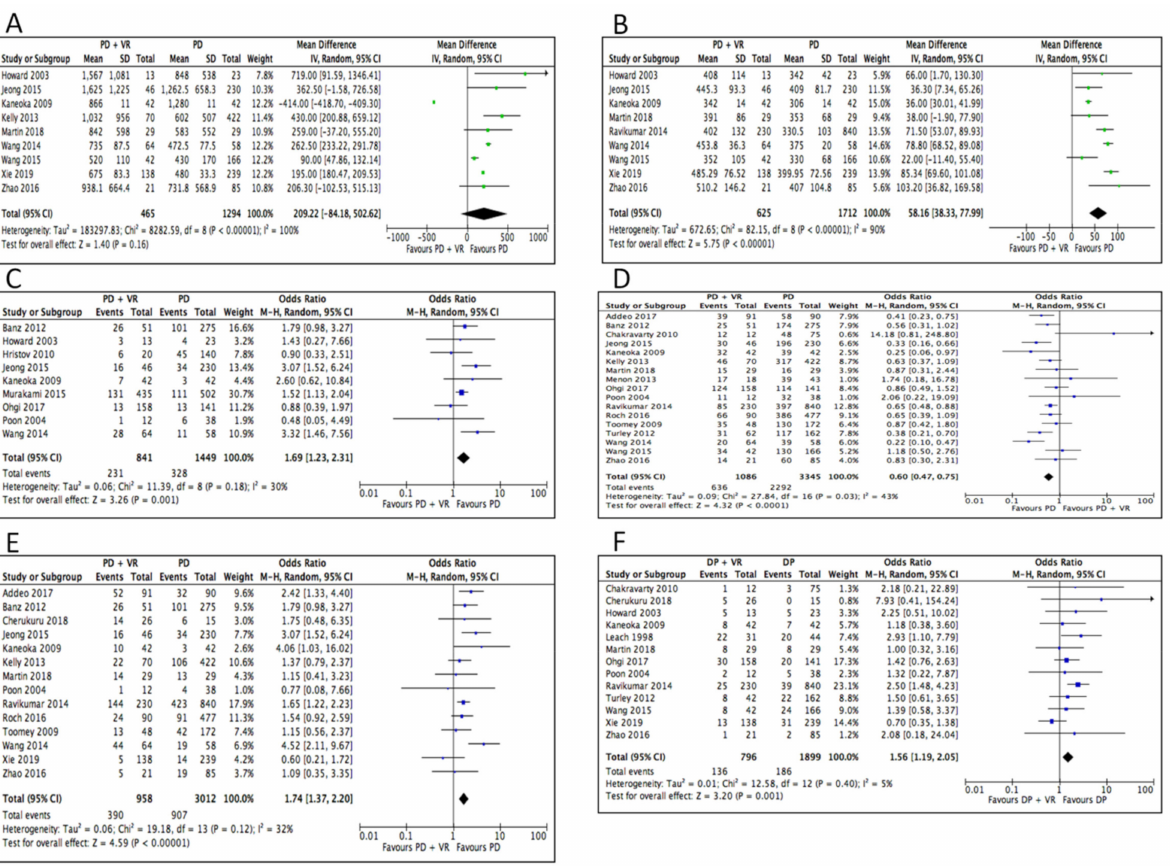
Figure 2. Meta-analysis of operative outcomes. ( A ) Blood loss. ( B ) Operative time. ( C ) Positive margin status. ( D ) R0 resection. ( E ) R1 resection. ( F ) Delayed gastric